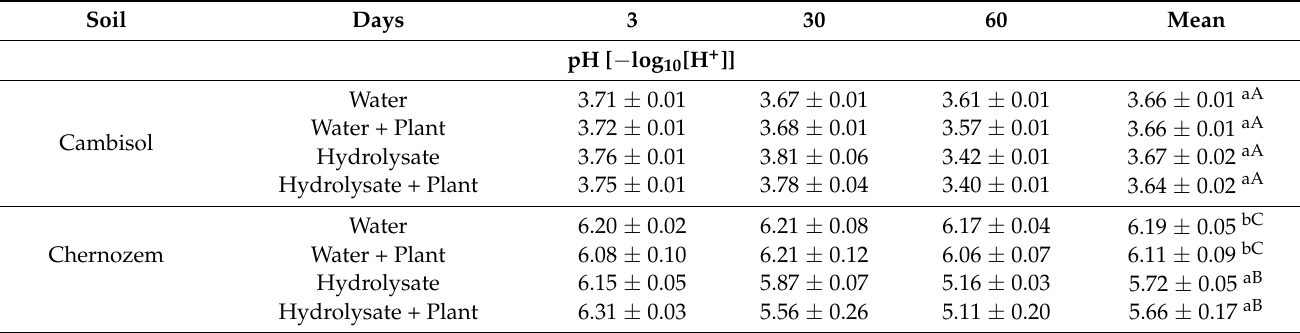
Table 3. Dynamics of changes of soil